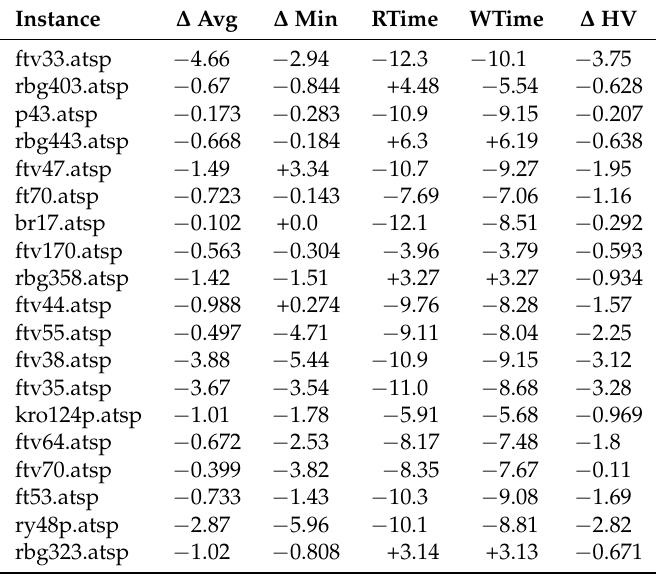
Table 1. Results from running Multistart and Multiverse Genetic Algorithm on TSPLIB instances.